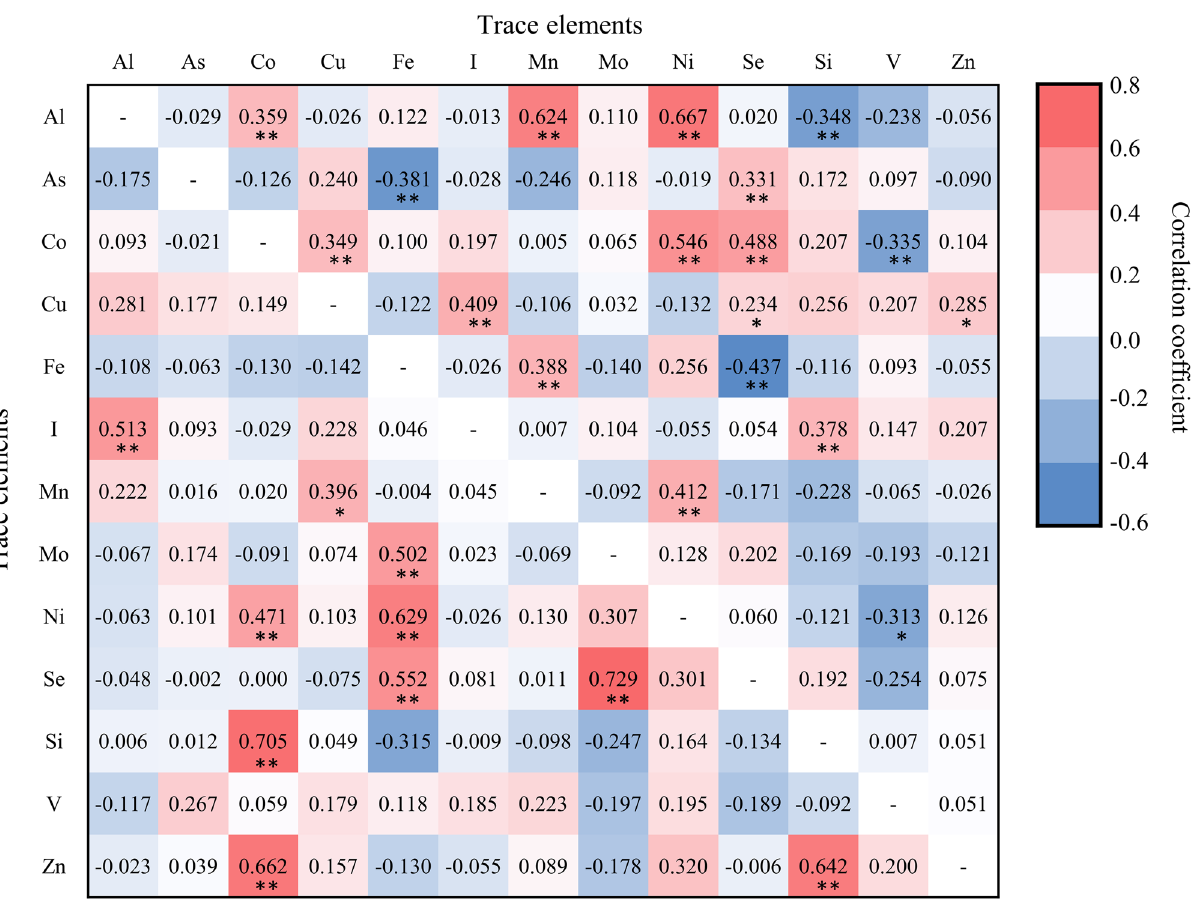
Figure 5. Correlation matrix for selected trace elements in surface waters from the non-KBD (upper right) and KBD (lower left) areas in the Longzi County. *Correlation is significant at p < 0.05 level; **correlation is significant at p < 0.01 level.